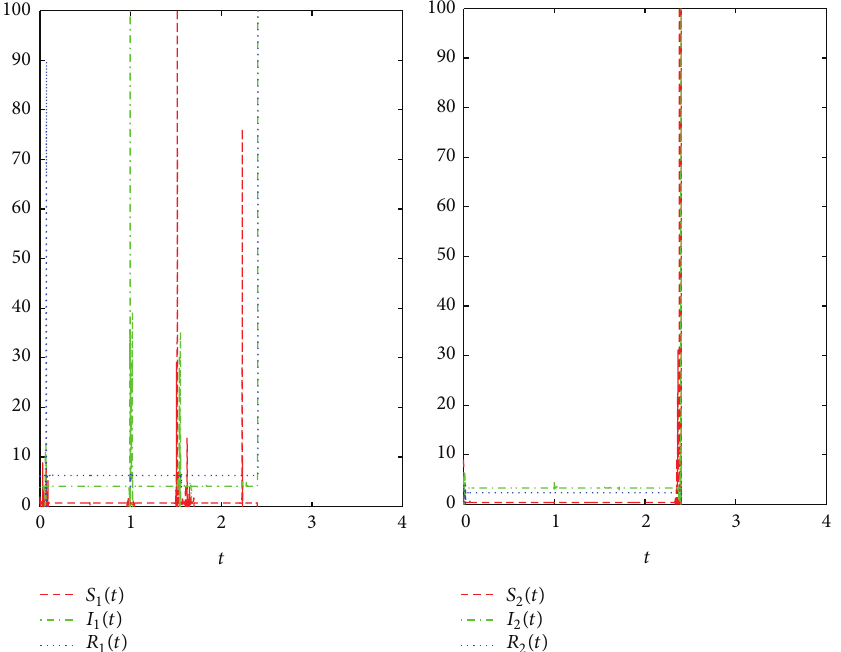
Figure 4: Stochastic trajectories of SIRS model (12) for 𝜎 11 = 40.5 , 𝜎 21 = 32.73 , 𝜎 31 = 36.92 , 𝜎 12 = 33.4 , 𝜎 22 = 39.67 , and 𝜎 32 = 30.5